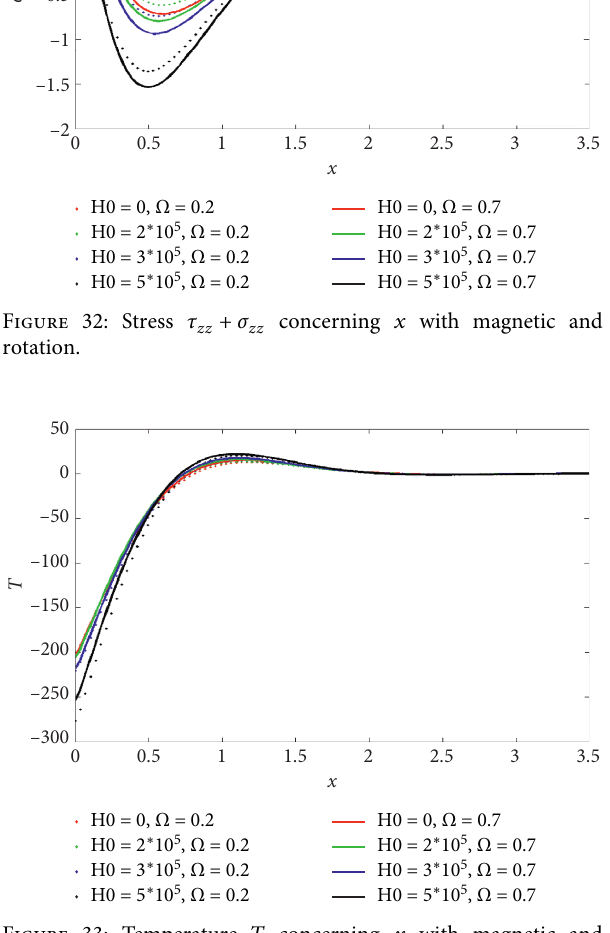
Figure 33: Temperature T concerning x with magnetic and